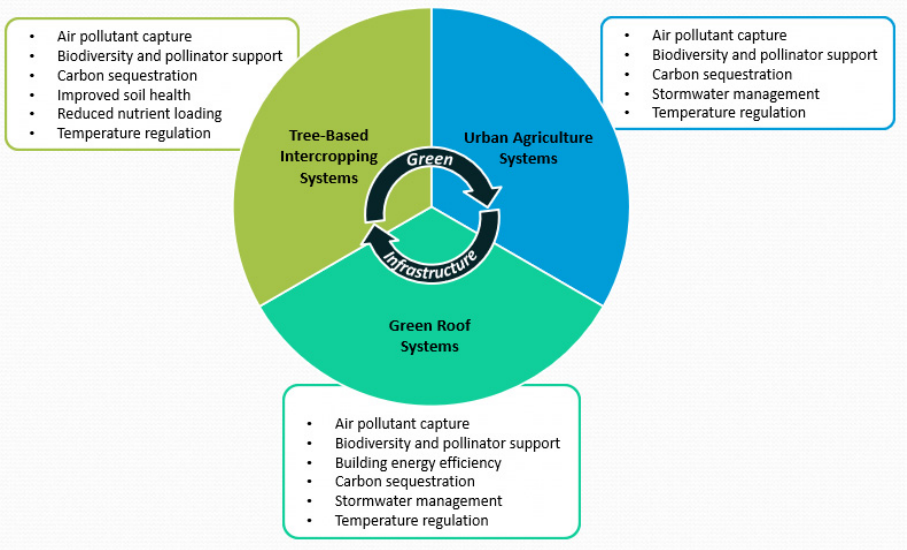
Figure 1. Green infrastructure form and function [14–19].